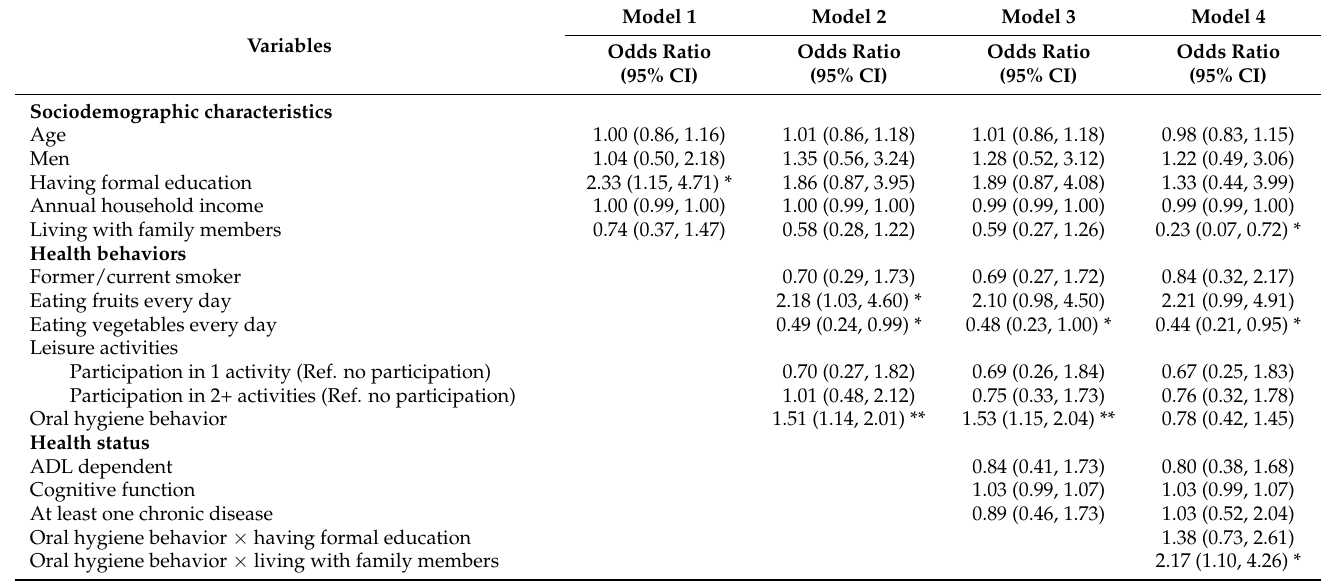
Table 3. Logistic regression analysis results for edentulous status among longevous persons ( n =